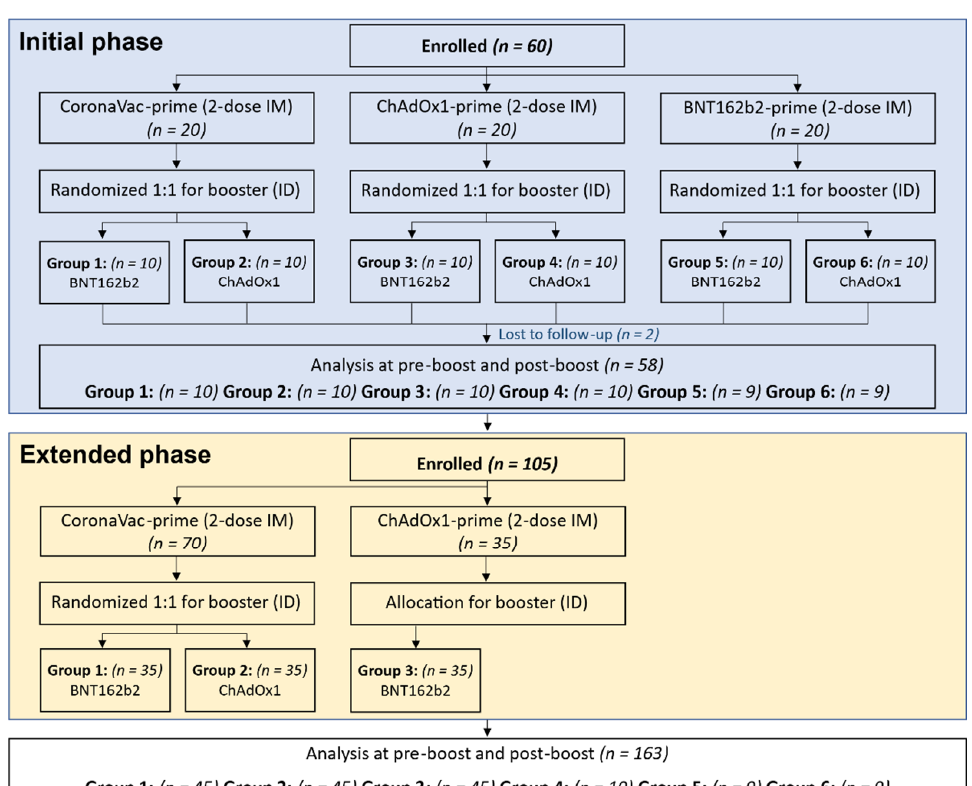
Figure 1. Consort Diagram showing enrollment of each group in initial phase and extended phase. Group 1 and 2 received two doses of CoronaVac intramuscularly (CoronaVac-prime), Group 3 and 4 received two doses of ChAdOx1 intramuscularly (ChAdOx1-prime), and Group 5 and 6 received two doses of BNT162b2 intramuscularly (BNT162b2-prime). Each group was randomized to receive intradermal BNT162b2 (0.05 mL, 1/6th of standard dosage) or ChAdOx1 (0.1 mL, 1/5th of standard